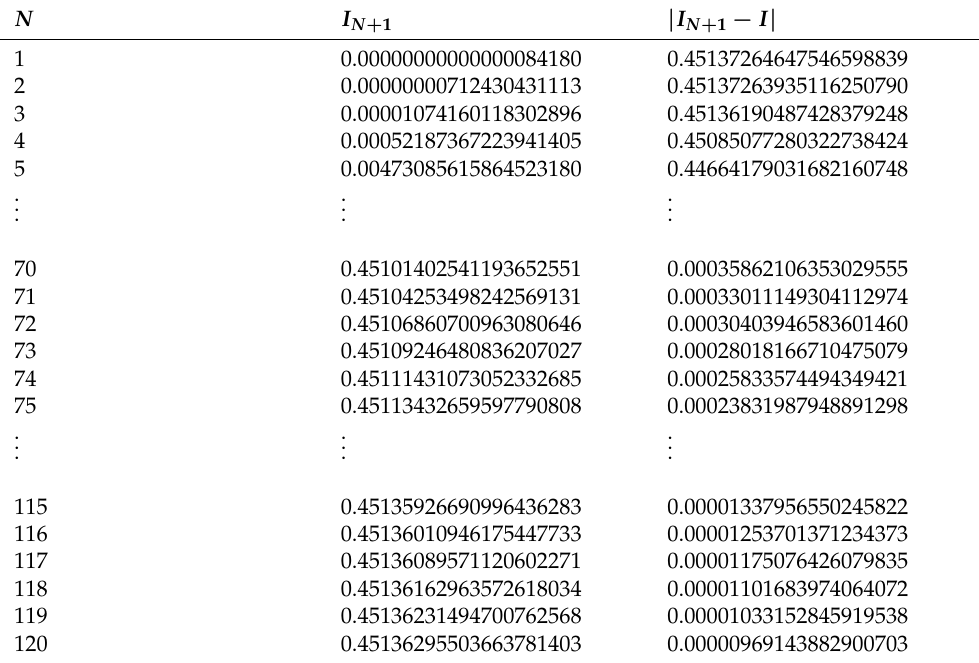
Table 1. The numerical results of the reverse osmosis (RO) system using the single exponential (SE)-Sinc integration rule for ε = 10 − 5 based on the floating point arithmetic (FPA). N I N +